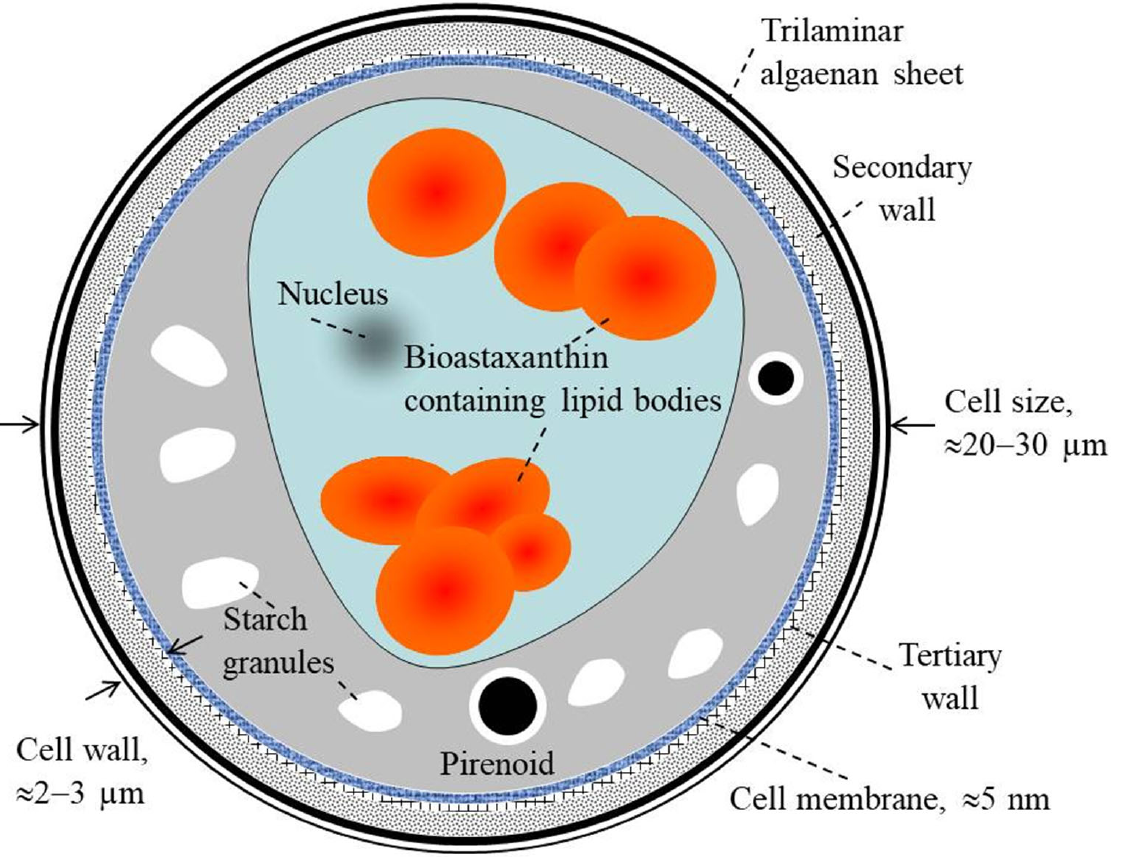
Figure 2. Description of H. pluvialis cell structure at the resistant cyst stage. Based on the data collected in [62–67].